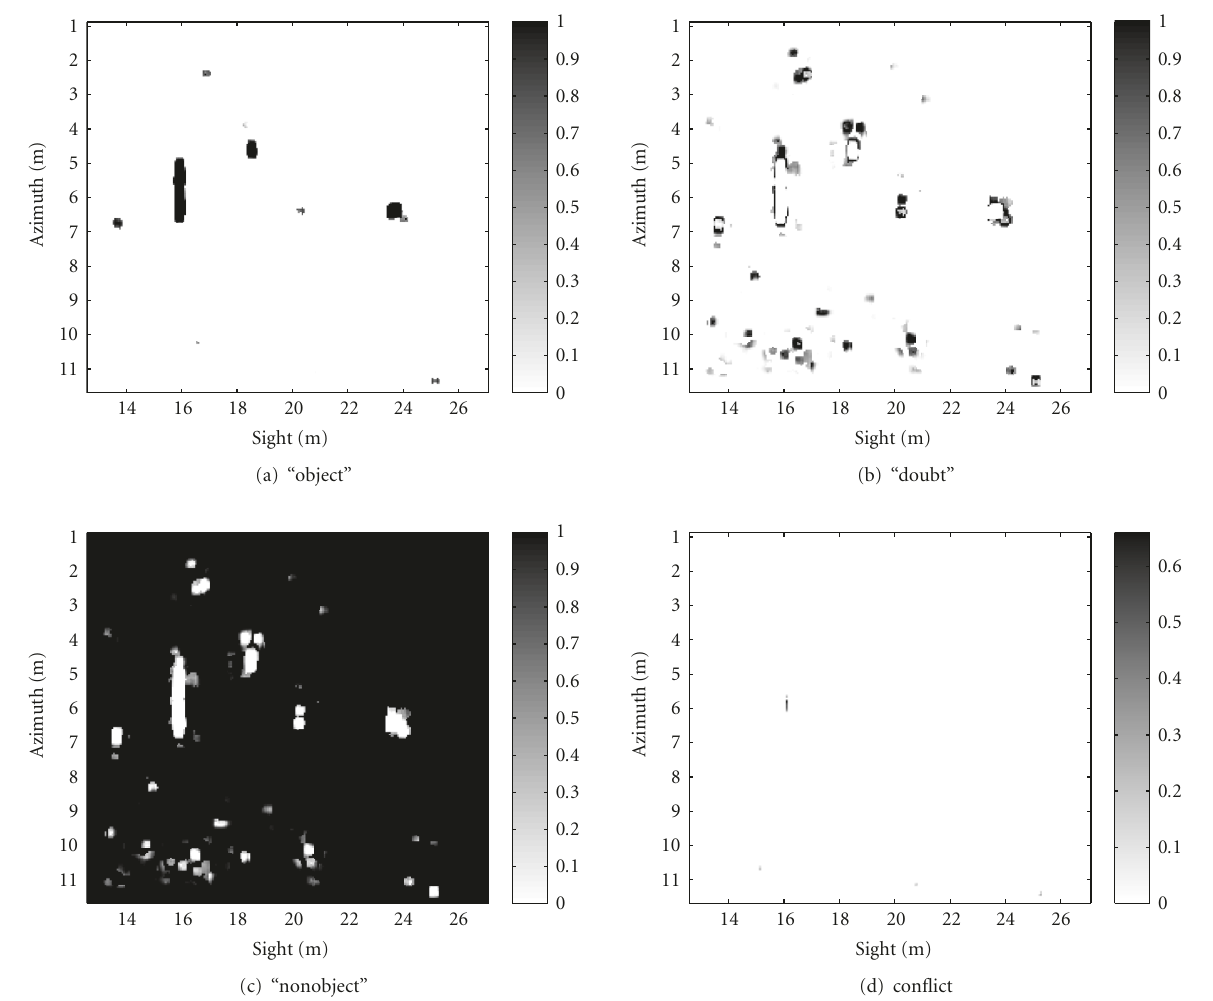
Figure 16: Mass images obtained after fusion of the three parameters in image 1.